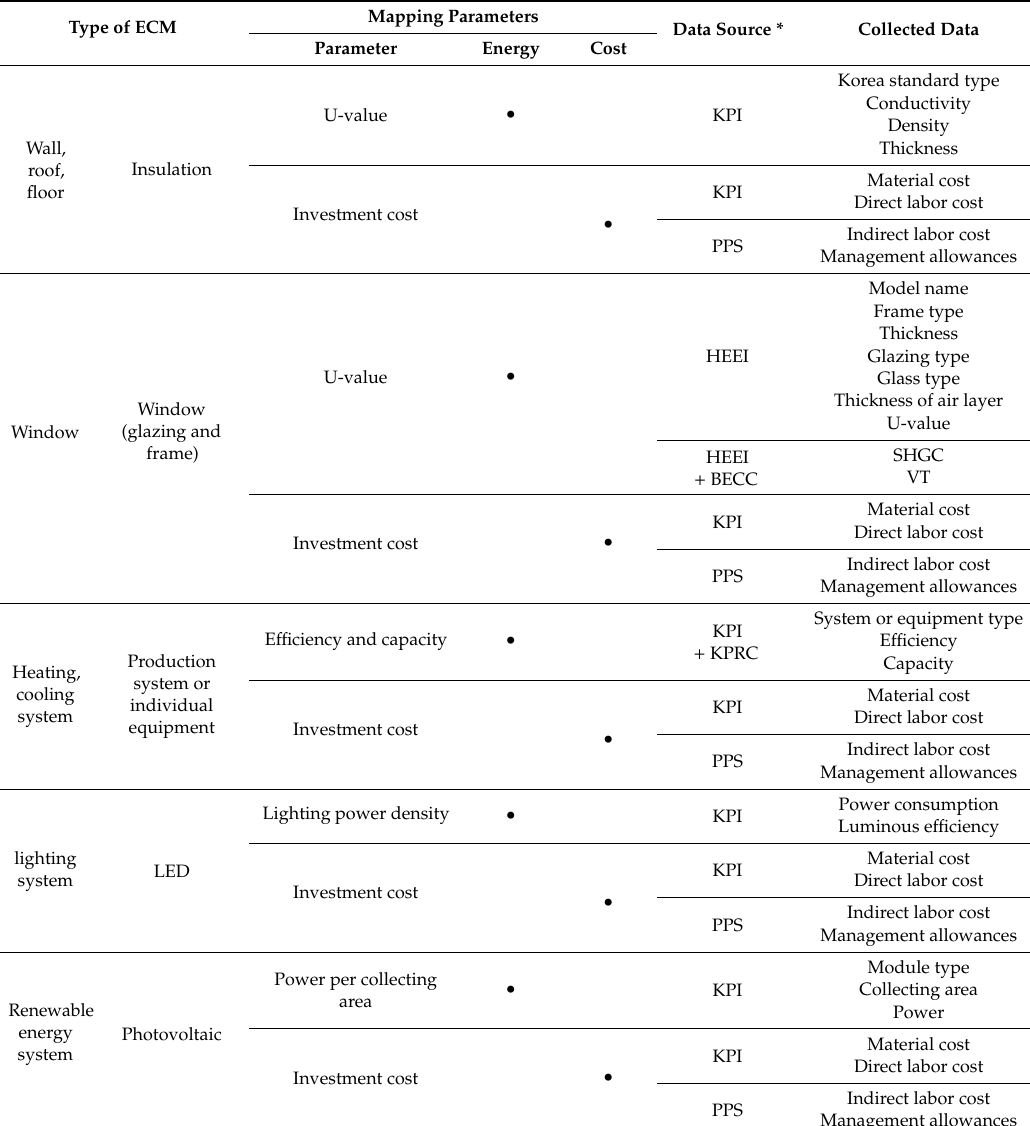
Table 1. Energy performance parameters and cost information mapping